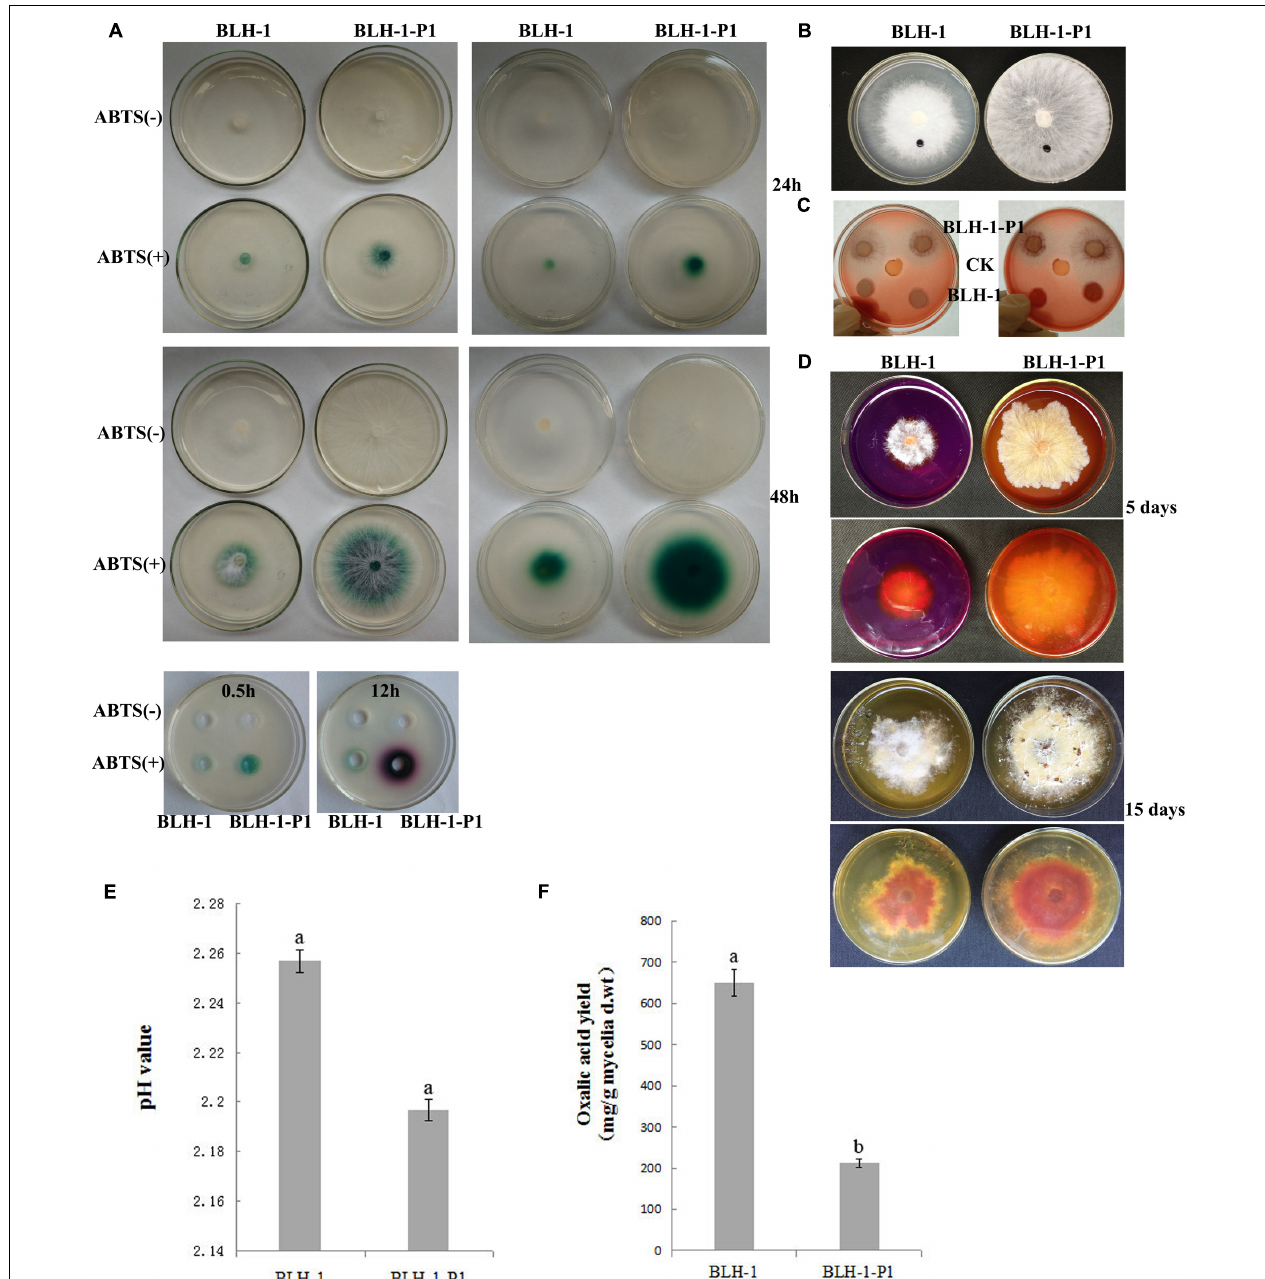
FIGURE 8 | Assays for laccase activity, cellulase activity, acid-producing ability, ambient pH, yield of oxalic acid and the colony surface hydrophobicity. (A) Laccase activity was tested after placing mycelial agar plugs on PDA containing ABTS for 24 and 48 h. It was also assayed using mycelial culture filtrate dropped upon holes on the same PDA agar. The images were collected after the culture filtrates were dropped for 0.5 and 12 h. (B) Colony surface hydrophobicity test using bromophenol blue. (C) Cellulase activity assays of the two strains by examination of the formation of bright yellow color around the fungal colonies. (D) Acid-producing ability was evaluated by culturing the mycelial agar plugs on PDA containing 0.01% bromophenol blue for 5 and 15 days, respectively; acid production was indicated by appearance of yellow in the culture medium. (E) pH values of cultures of strains BLH-1 and BLH-1-P1 that inoculated in PD for 5 days. (F) The amount of oxalic acid produced by the strains of BLH-1 and BLH-1-P1 were assessed by high-performance liquid chromatography.